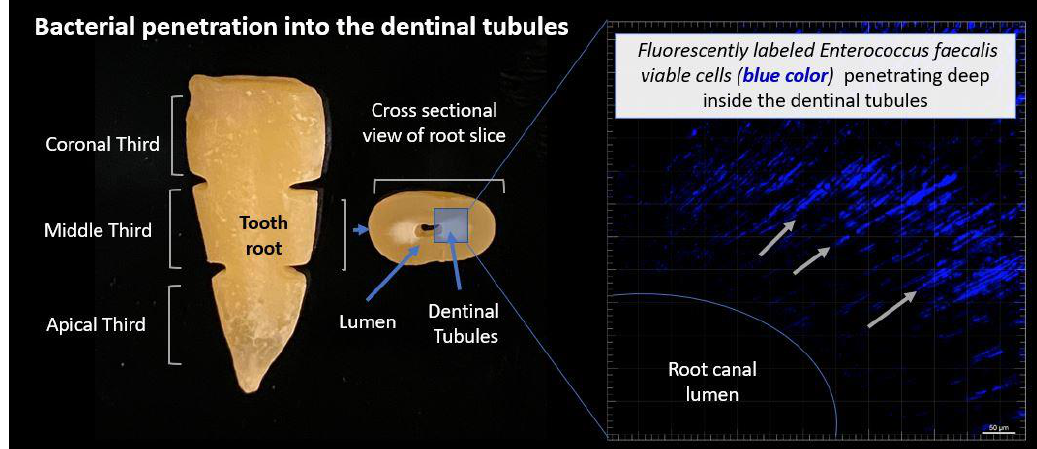
Figure 1. Representative confocal microscopic image of Enterococcus faecalis colonizing inside dentinal tubules (20× magnification) may complicate the chemo-mechanical disinfection of root canal therapy.